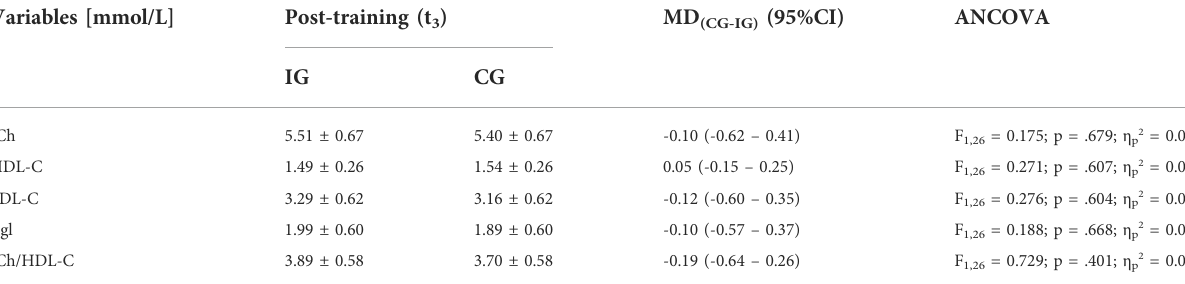
TABLE 3 Chronic effects of IHHE (IG) and sham IHHE (CG) prior to aerobic cycling training on lipid and lipoprotein concentrations in blood serum. Data are depicted as baseline-adjusted post-training values as well as mean differences (MD) (95% con fi dence intervals [CI]). Variables